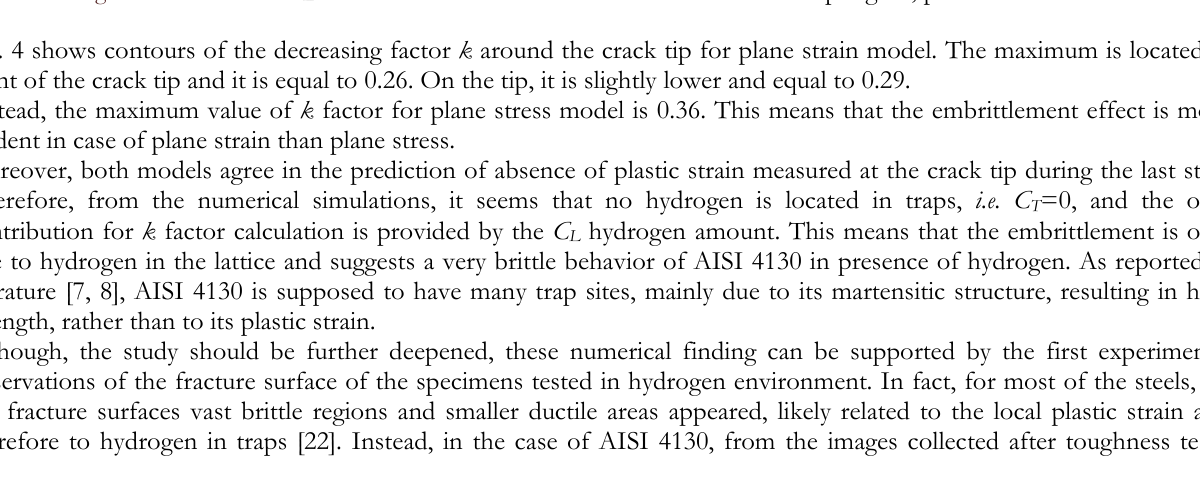
Figure 3: Contours of C L concentration in lattice interstitial sites at crack tip region, plane strain